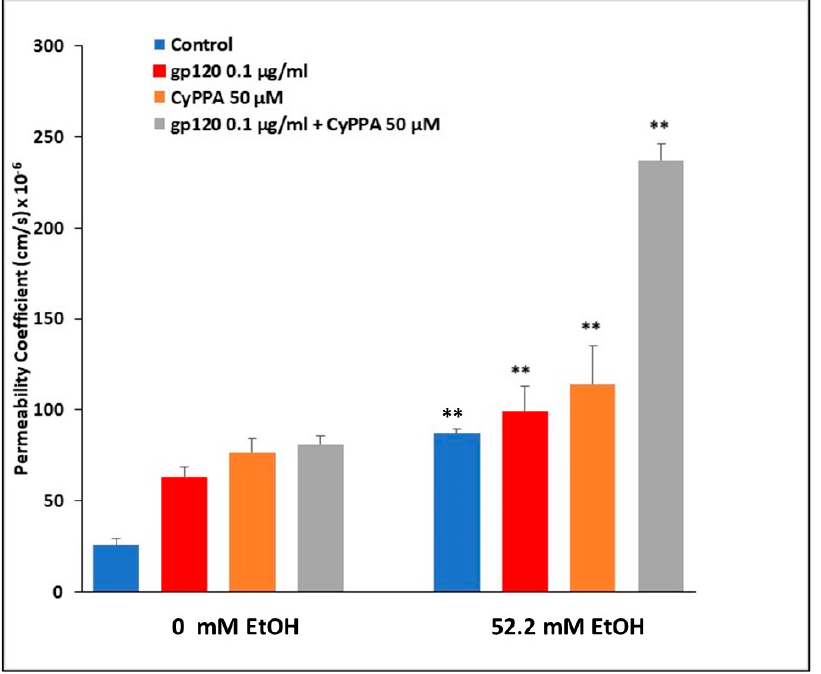
Figure 7. Human BMVEC in vitro BBB model. Cells were seeded into Corning transwell plate inserts and grown for three days, to allow a barrier to form as confirmed by TEER measurements. Media only was added to wells to account for background. BMVECs were treated with either 0 or 52.2 mM EtOH, 50 μ M TRPM7 antagonist (CyPPA), 0.1 μ g/mL HIV-1 gp120, alone and in combination treat- 50 µ M TRPM7 antagonist (CyPPA), 0.1 µ g/mL HIV-1 gp120, alone and in combination treatment conditions. Ten µ g/mL of Sodium Fluorescein (NaF) was added to each insert for